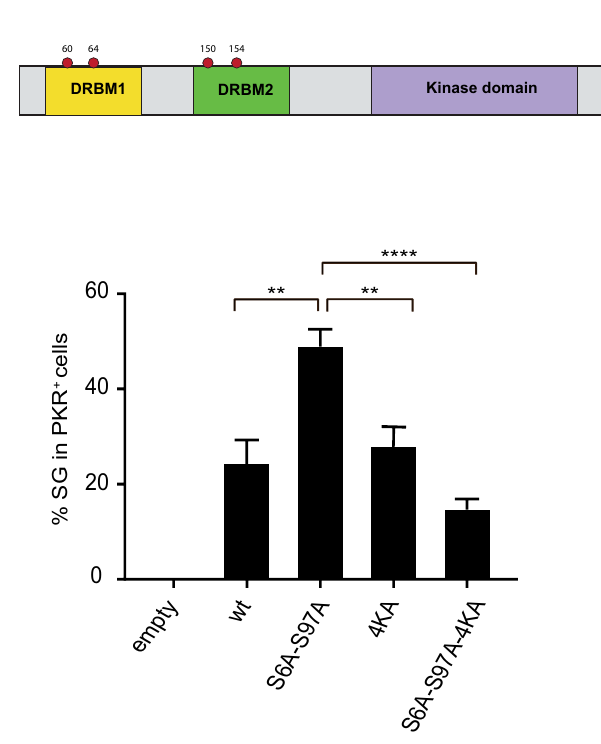
Figure 4. dsRNA binding contributes to spontaneous activation of S6A-S97A PKR mutant. ( a ) Schematic representation of the main PKR domains. The coordinates on the top are those of the four lysines mutated to alanines in order to generate a DRBM-dead PKR (PKR-4KA). ( b ) PKR-KO cells were transfected with plasmids expressing PKR mutants and fixed 48 h post-transfection for eIF3 and PKR detection by immunofluorescence. Graphs (generated with Microsoft Excel 2011) show the mean and SEM of the percentages of stress granule- positive cells counted among PKR + cells (n = 4). 1-way ANOVA (Graphpad Prism 7) compared each PKR condition to the S6A-S97A PKR mutant